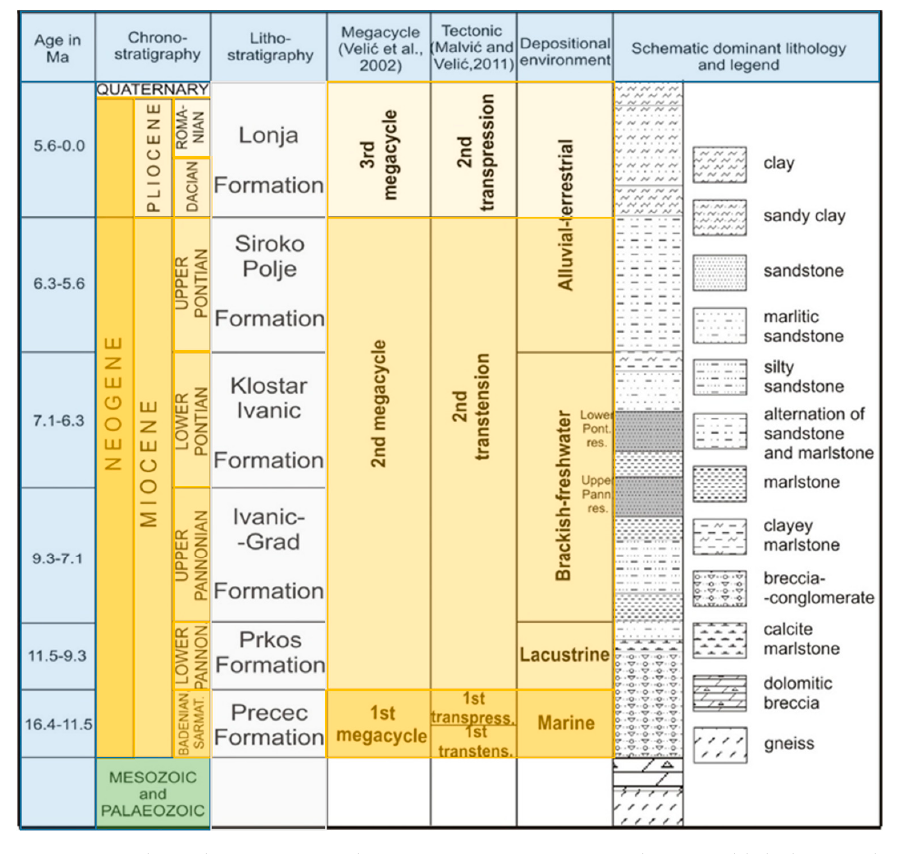
Figure 1. Stratigraphic column, megacycles, environments, tectonic phases and lithology in the Sava Depression [28]. Depression